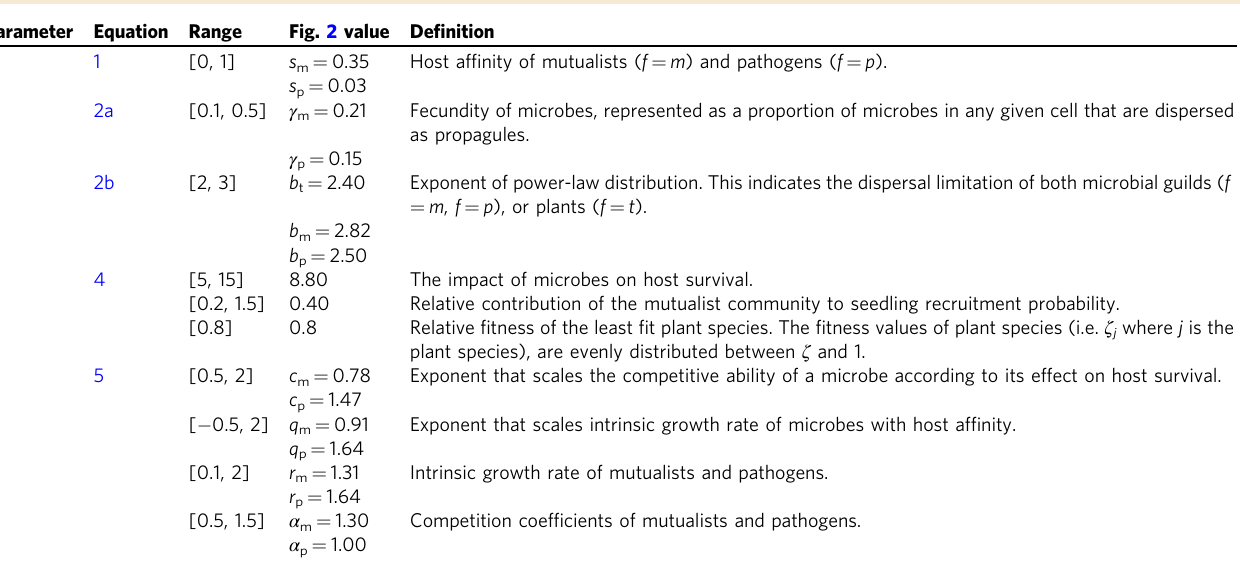
Parameter ranges represent the total range over which parameters were allowed to vary between runs. Values represent the values identi fi ed by a random forest model as most likely to drive a positive correlation between host abundance and feedback (i.e. those used in simulation runs depicted in Fig. 2). See Supplementary Table 1 for expanded parameter descriptions.